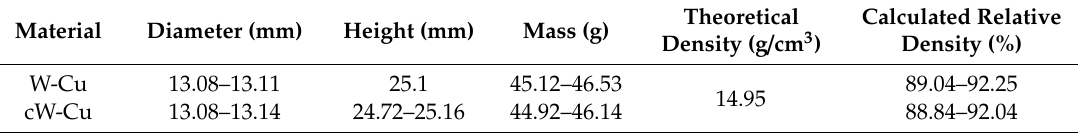
Table 1. Table 1. The geometrical data of the manufactured W-Cu and cW-Cu Table 1. The geometrical data of the manufactured W-Cu and cW-Cu specimens.